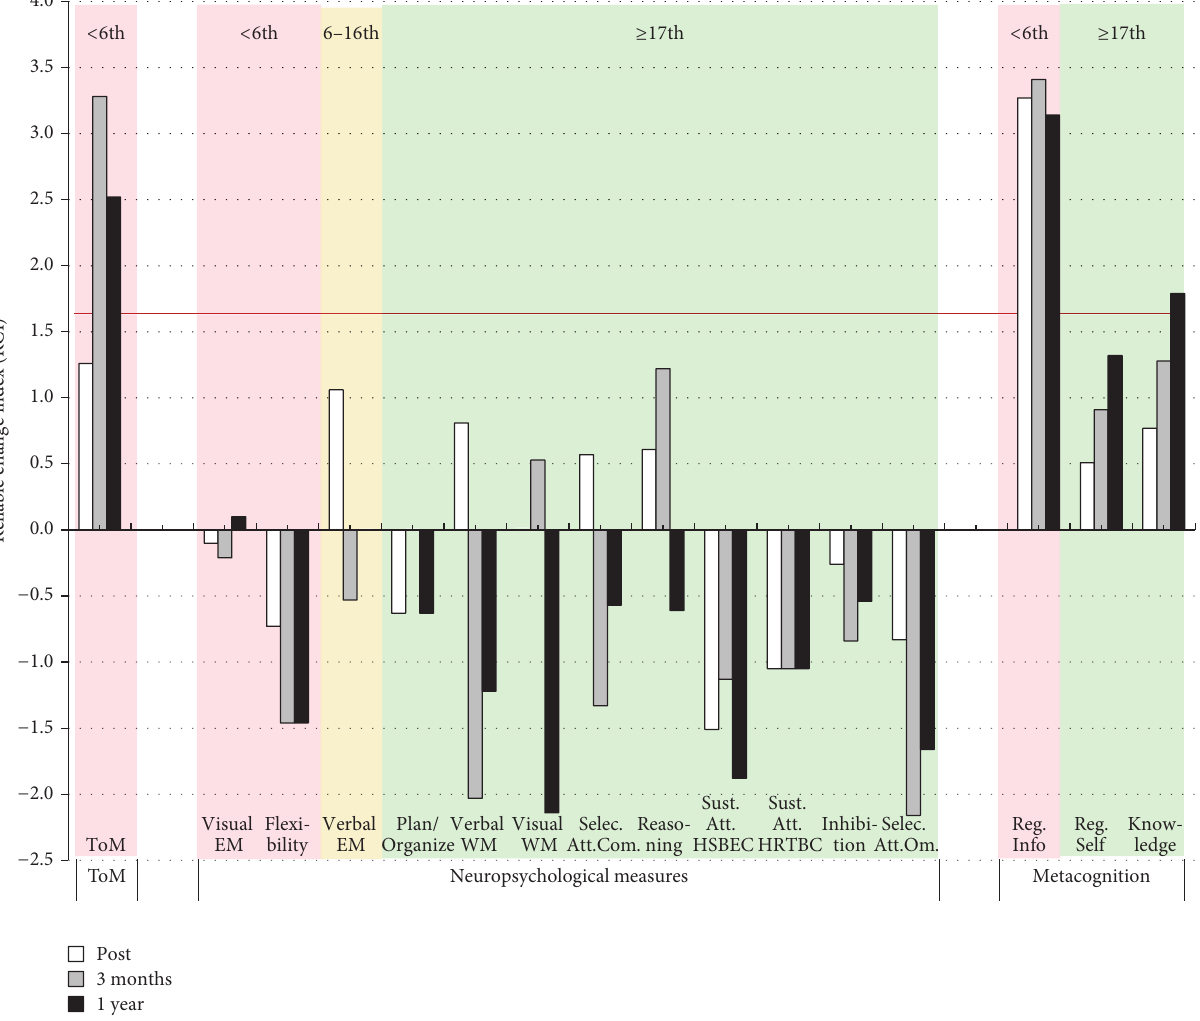
Figure2:ChangesinToMandneuropsychologicalandmetacognitiveresultsforCaseAforeachofthefollow-upassessments(posttreatment, 3 months and 1 year after treatment). The color of the background indicates the severity of the deficit at baseline. A red background indicates a severe impairment at baseline ( ≤ 6th percentile), a yellow background indicates an important impairment (7th to 16th percentile), and a green background indicates a normal performance ( ≥ 17th percentile). The horizontal red line indicates the statistical RCI threshold of 1.64. ToM = theory of mind; EM = episodic memory; WM = working memory; selec. att. = selective attention; com. = commission; sust. att.